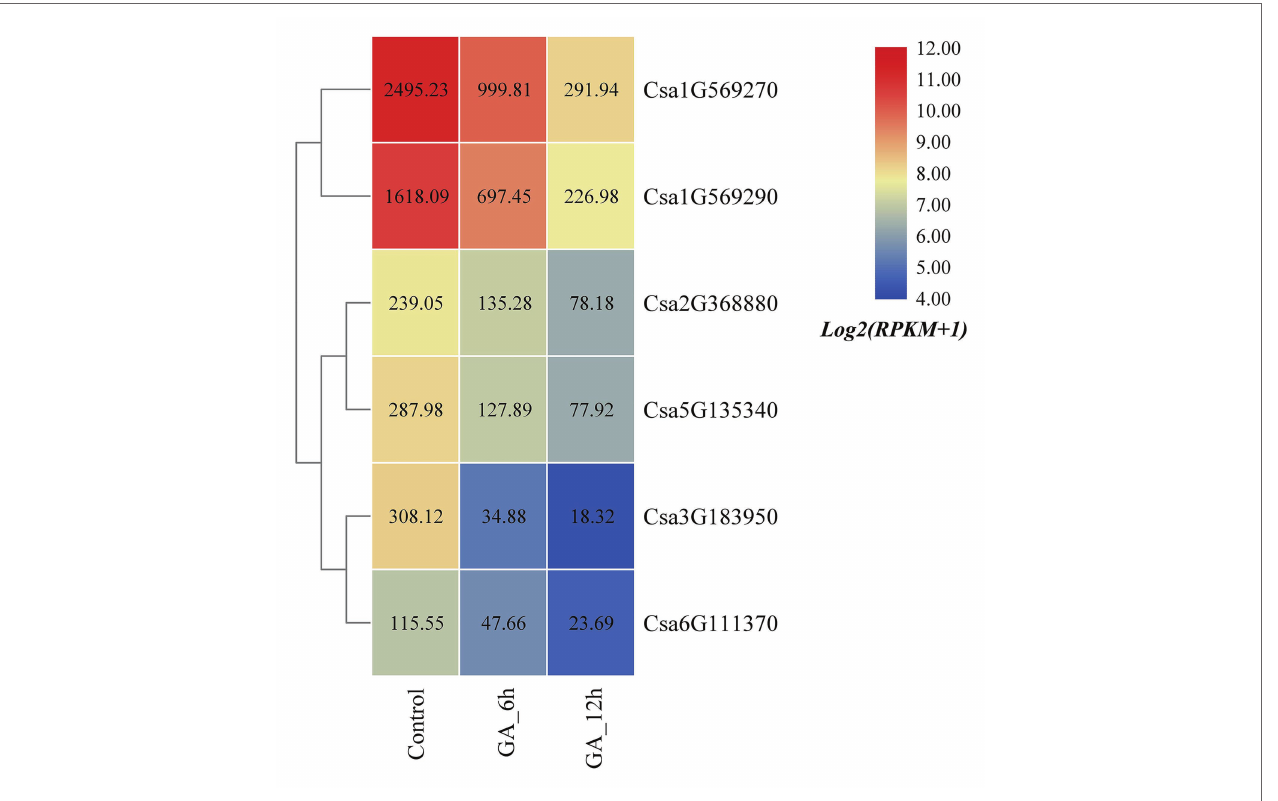
FIGURE 8 | The expression heatmap of the cucumber HSP90 gene family under GA treatment. Control is the control sample; GA_6h is the sample treated with GA for 6 h; GA_12h is the sample treated with GA for 12 h. The data in the boxes indicate original RPKM